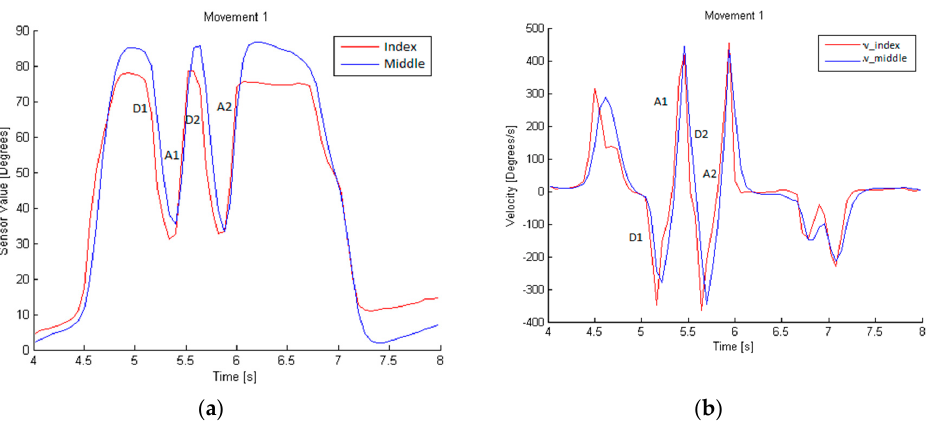
Figure 7. ( a ) Glove sensor data, which are proportional to the flexion of the finger in movement 1; ( b ) Velocity of flexion involved in movement 1. ( b ) Velocity of flexion involved in movement